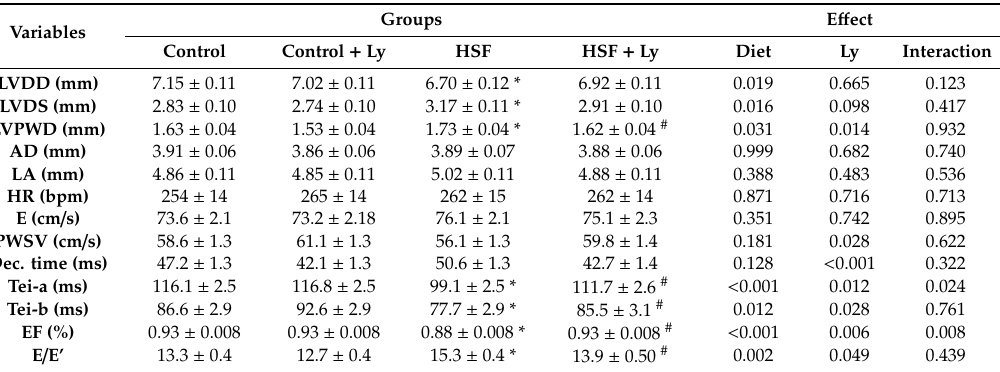
Table 2 . Echocardiographic study. Table 2. Echocardiographic